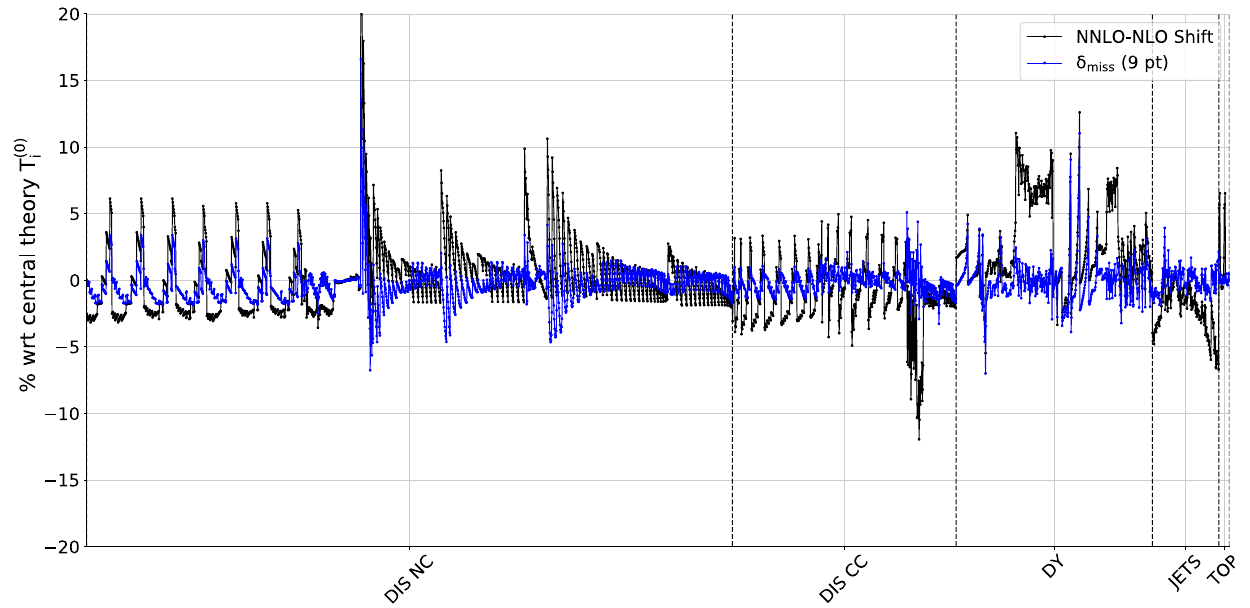
Fig. 11 The NNLO-NLO shift δ i (black) compared to its component δ miss (blue) which lies outside the subspace S , computed using the 9-point